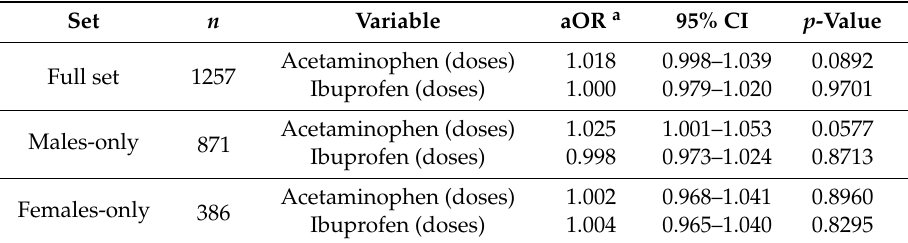
Table 4. Joint models for scaled variables.